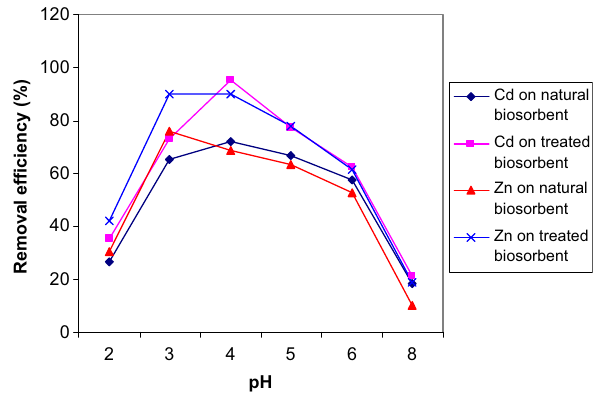
Fig. 3 Effect of biosorbent dosage on Cd and Zn biosorption